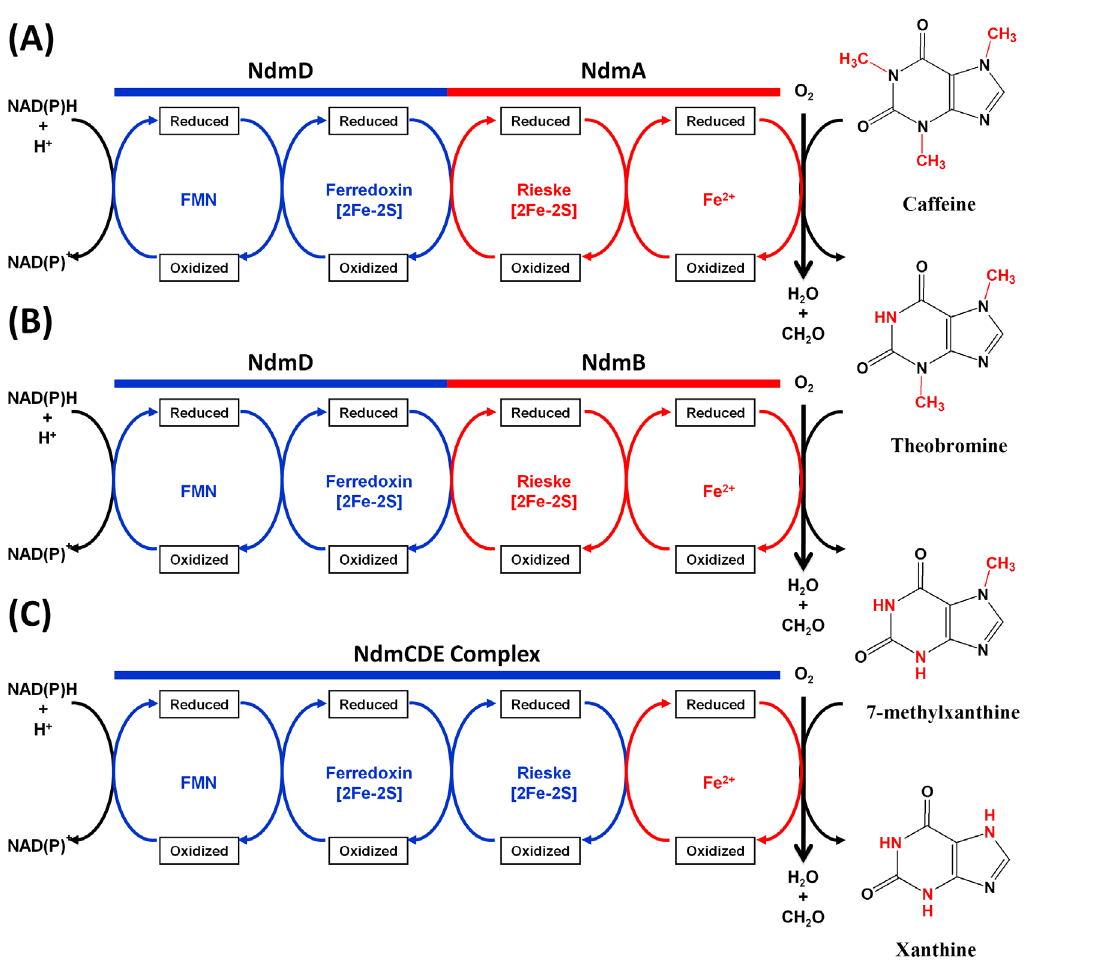
Figure 2. Proposed electron transfer scheme showing redox groups involved in the complete N -demethylation of caffeine to xanthine. (A) N demethylation of caffeine to theobromine by NdmA and NdmD. (B) N NdmD. (C) N -demethylation of 7-methylxanthine to xanthine by the NdmCDE complex. Redox groups in blue belong to NdmD, while 7 those in red belong to the oxygenase subunits (NdmA, NdmB, and